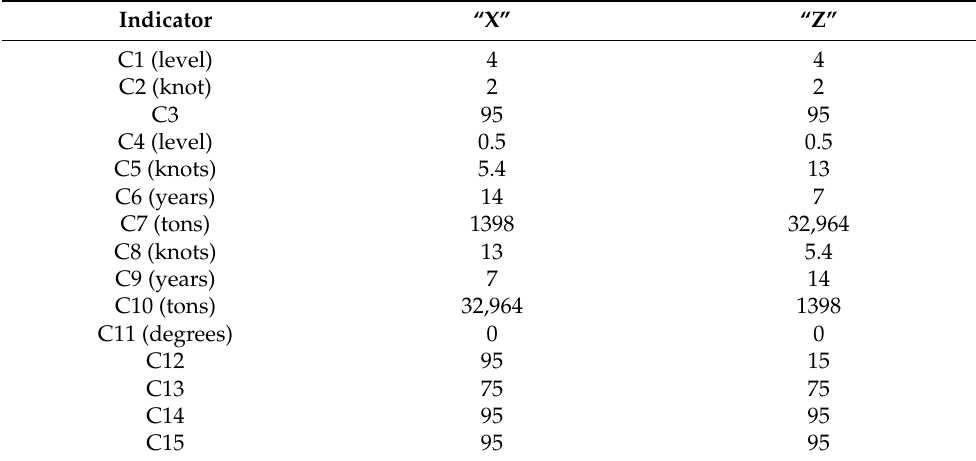
Table 11. Data of emergency situation after the collision in case 2.